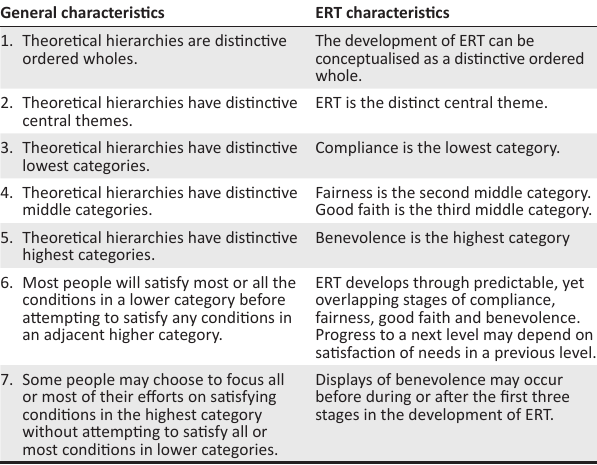
TABLE 4: Characteristics of theoretical